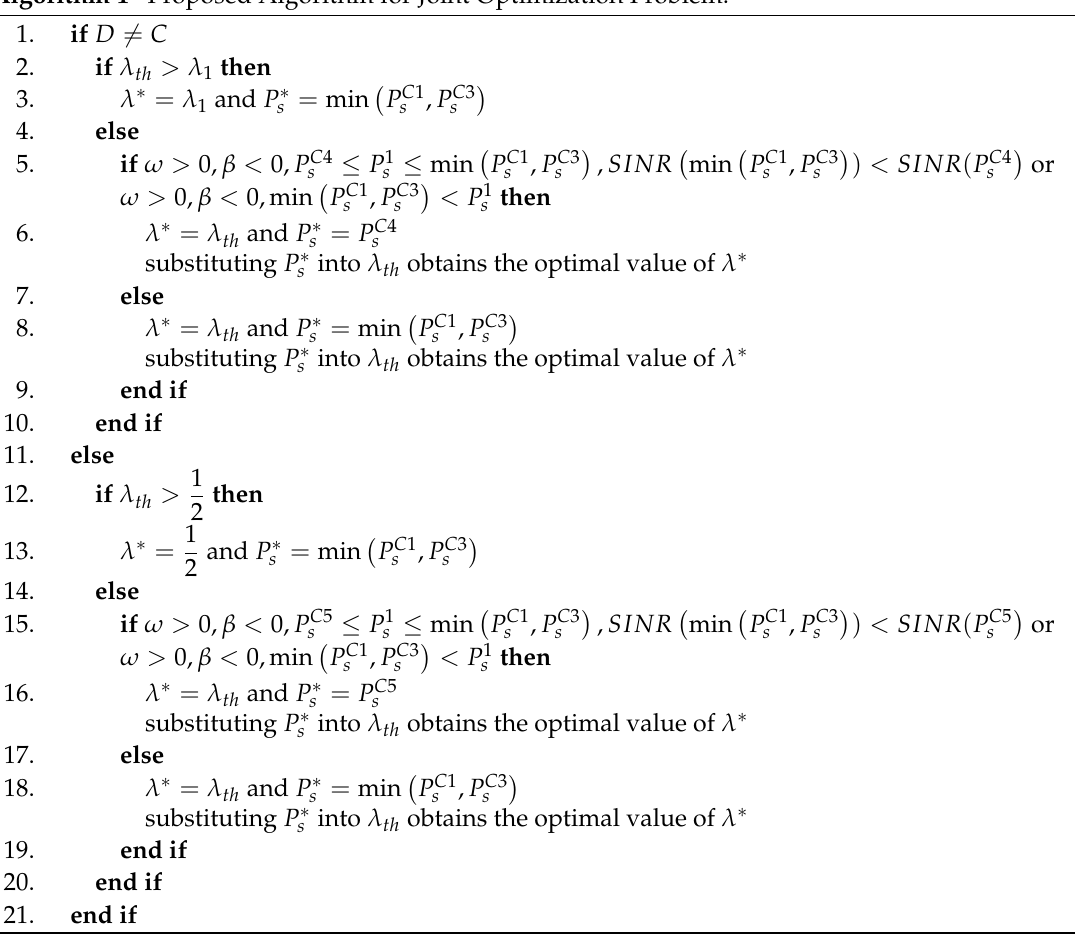
Algorithm 1 Proposed Algorithm for Joint Optimization